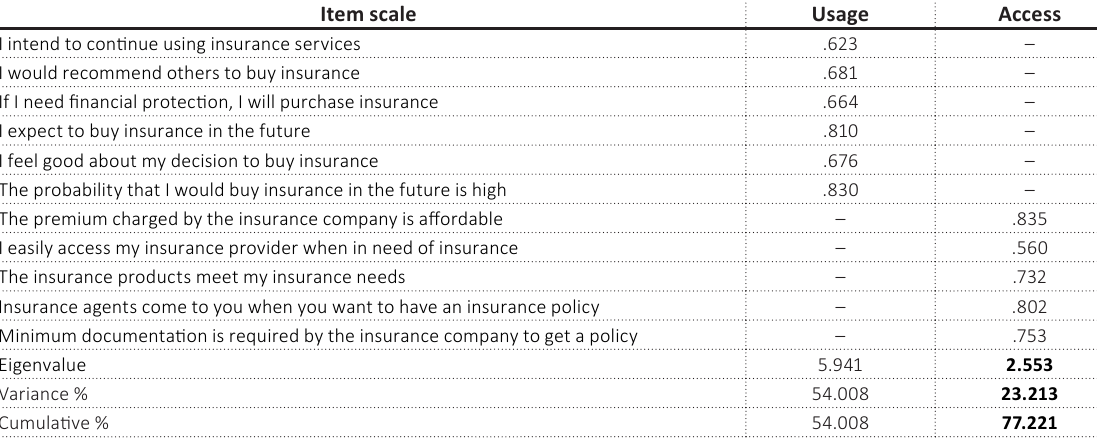
Table 2. Exploratory factor analysis for insurance inclusion Item scale Usage